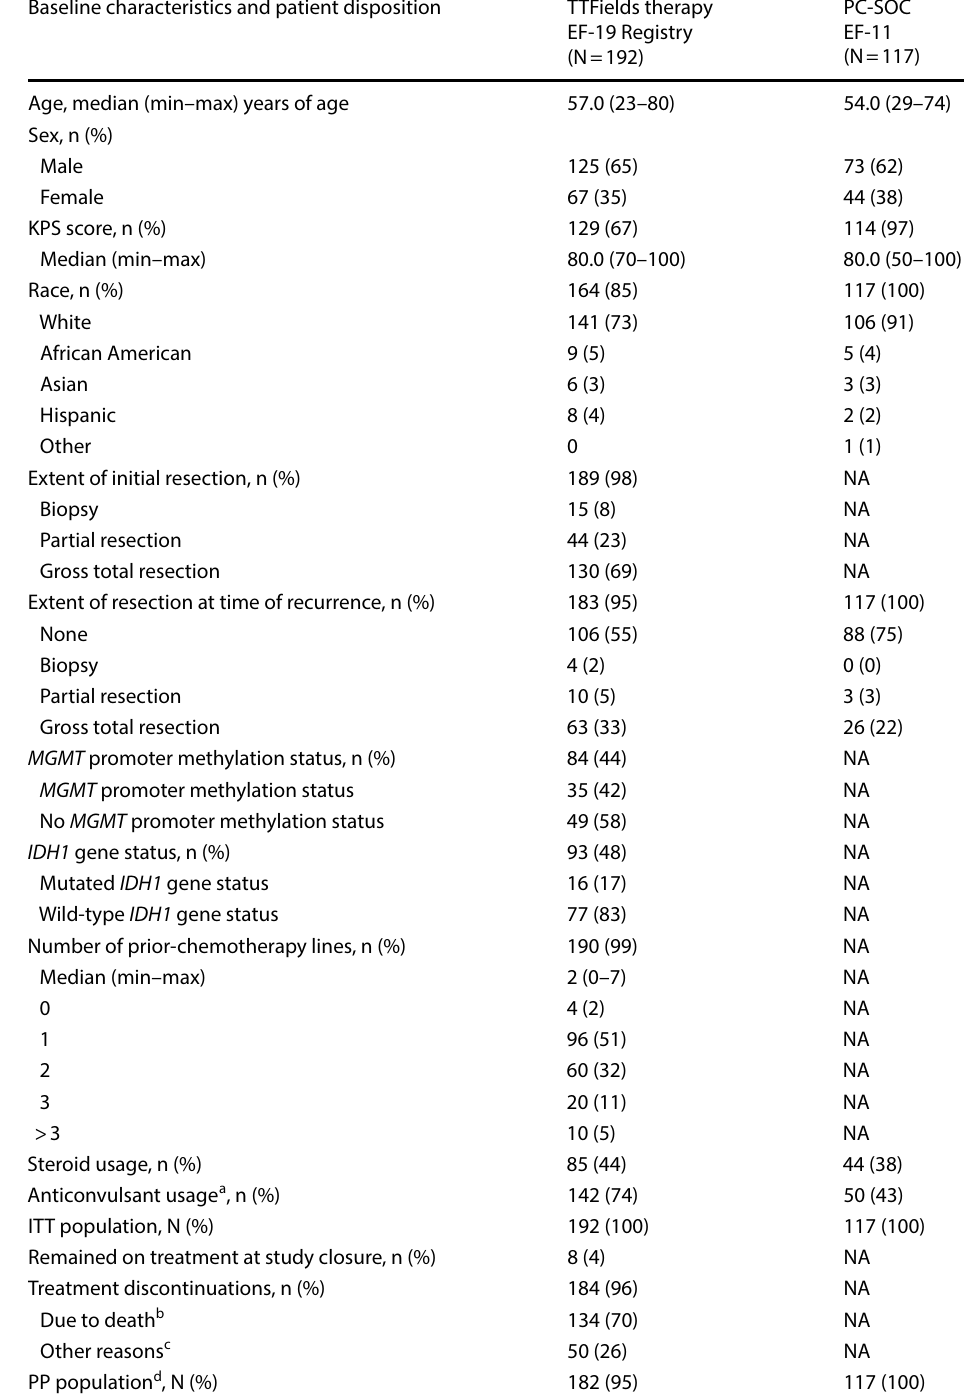
Baseline characteristics and patient